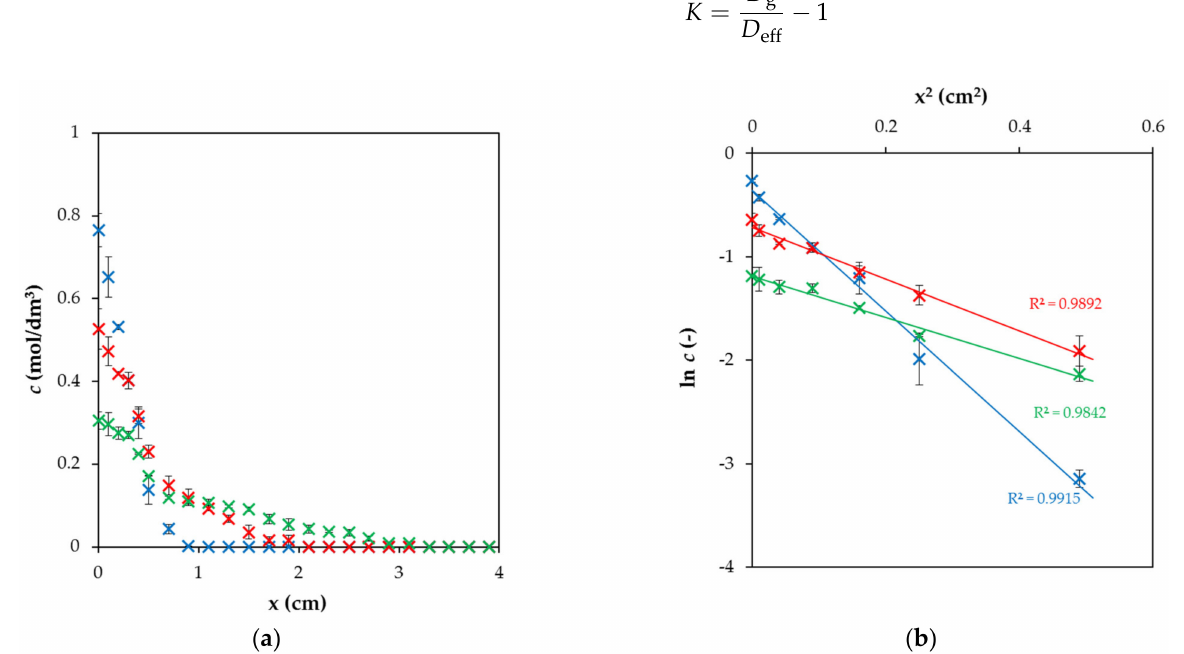
Figure 1. The example of experimental data: ( a ) Concentration profiles in agarose hydrogel enriched by ESHA in different times from the beginning of diffusion (6 h—blue, 24 h—red, 72 h—green); ( b ) The same experimental data linearized according to Equation (2).